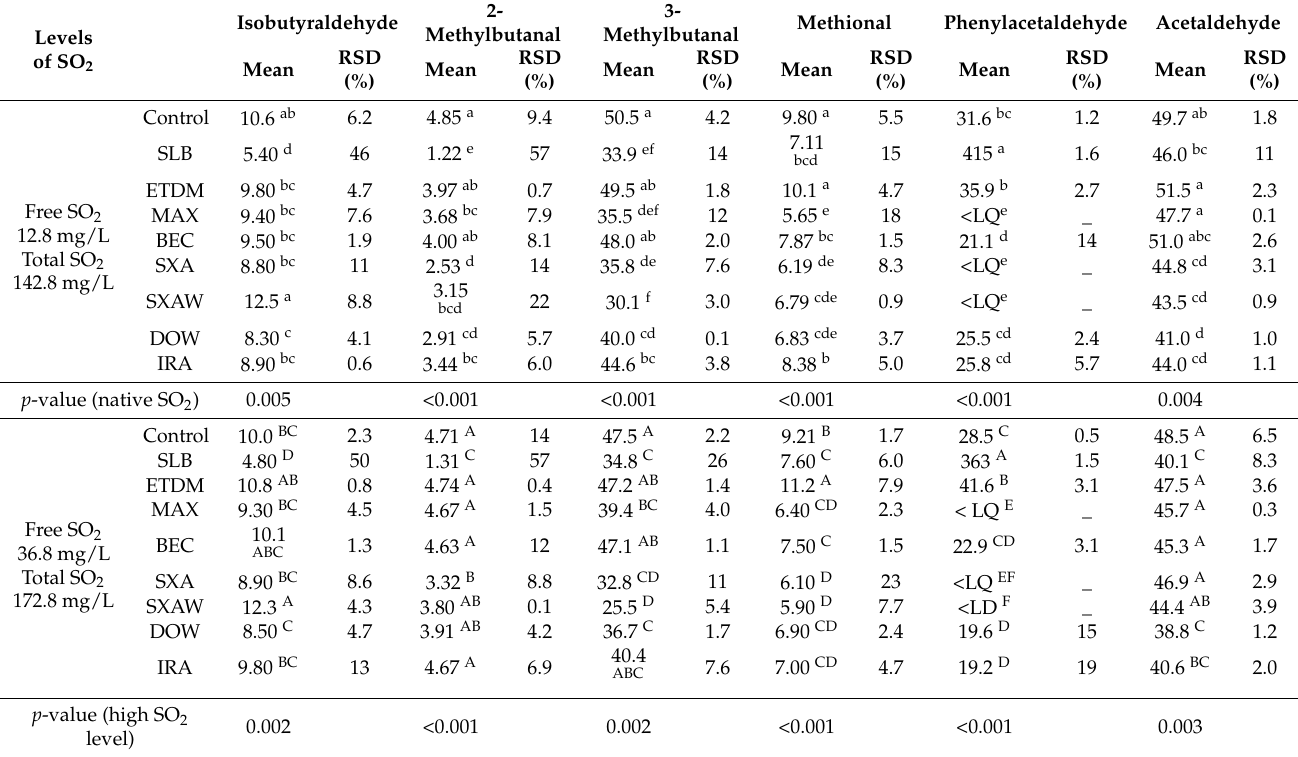
Table 5. Total Strecker aldehydes ( µ g/L) and acetaldehyde (mg/L) concentrations after 24 h at 25 ◦ C in contact with the